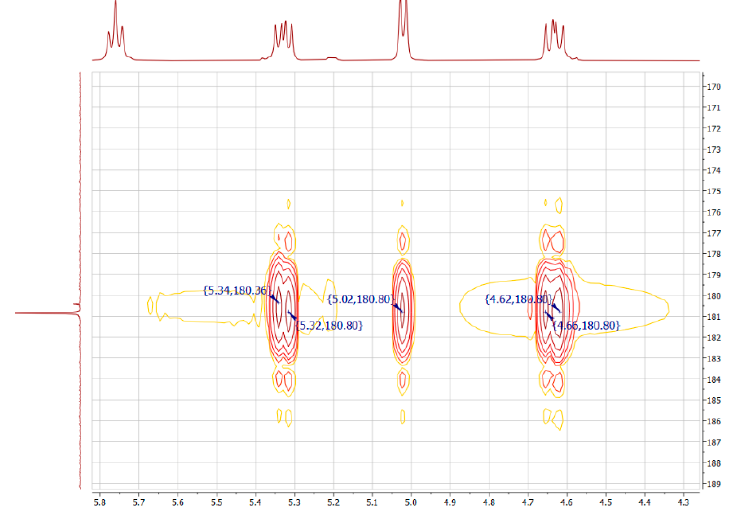
Figure 5. The range 190–170 ppm—5.8–4.4 ppm of 13 C— 1 H HMBC spectrum for 4,5-dihydroxy-1,3- bis(hydroxymethyl)imidazolidine-2-thione 6.